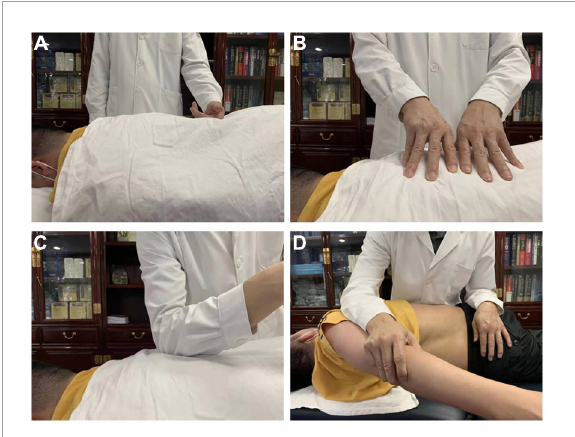
FIGURE1 Spinal Manipulative Therapy (SMT) performed by rolling (A) , kneading (B) , plunking (C) , pushing (D) to relax the muscles in the lower back area for the purpose of alleviating pain and improving lumbar